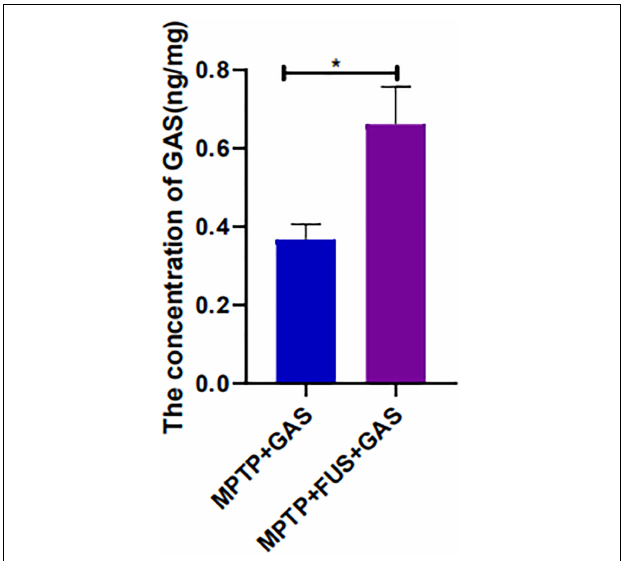
FIGURE 3 | Changes of GAS concentration in the mice’s left hemisphere of the MPTP + GAS group and the MPTP + FUS + GAS group. Compared to the MPTP + GAS group, * P < 0.05; T -test, n = 4, mean ± SEM.